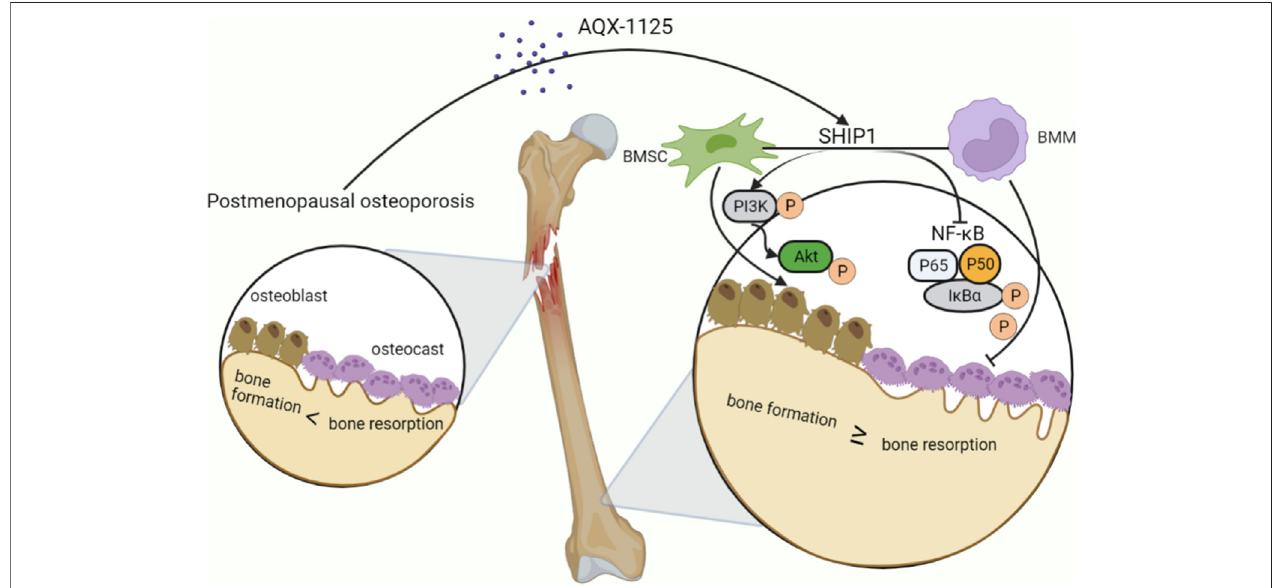
FIGURE 8 | AQX-1125 positively regulates osteogenesis through PI3K/Akt signaling and inhibits osteoclastogenesis through NF- κ b signaling via activation of SHIP1. Upon AQX-1125 stimulation, SHIP1 was activated in the BMSCs and BMMs. The activated SHIP1 facilitates the phosphorylation of PI3K and Akt in BMSCs, followed by acceleration of the differentiation of BMSCs into osteoblasts. In addition, activated SHIP1 inhibits the NF- κ b signaling pathway, which reduces the phosphorylation of p65 and IkB α in BMMs, followed by suppression of the differentiation of BMMs into osteoclasts and the activity of osteoclasts. Overall, AQX- 1125 alleviates OVX-induced bone